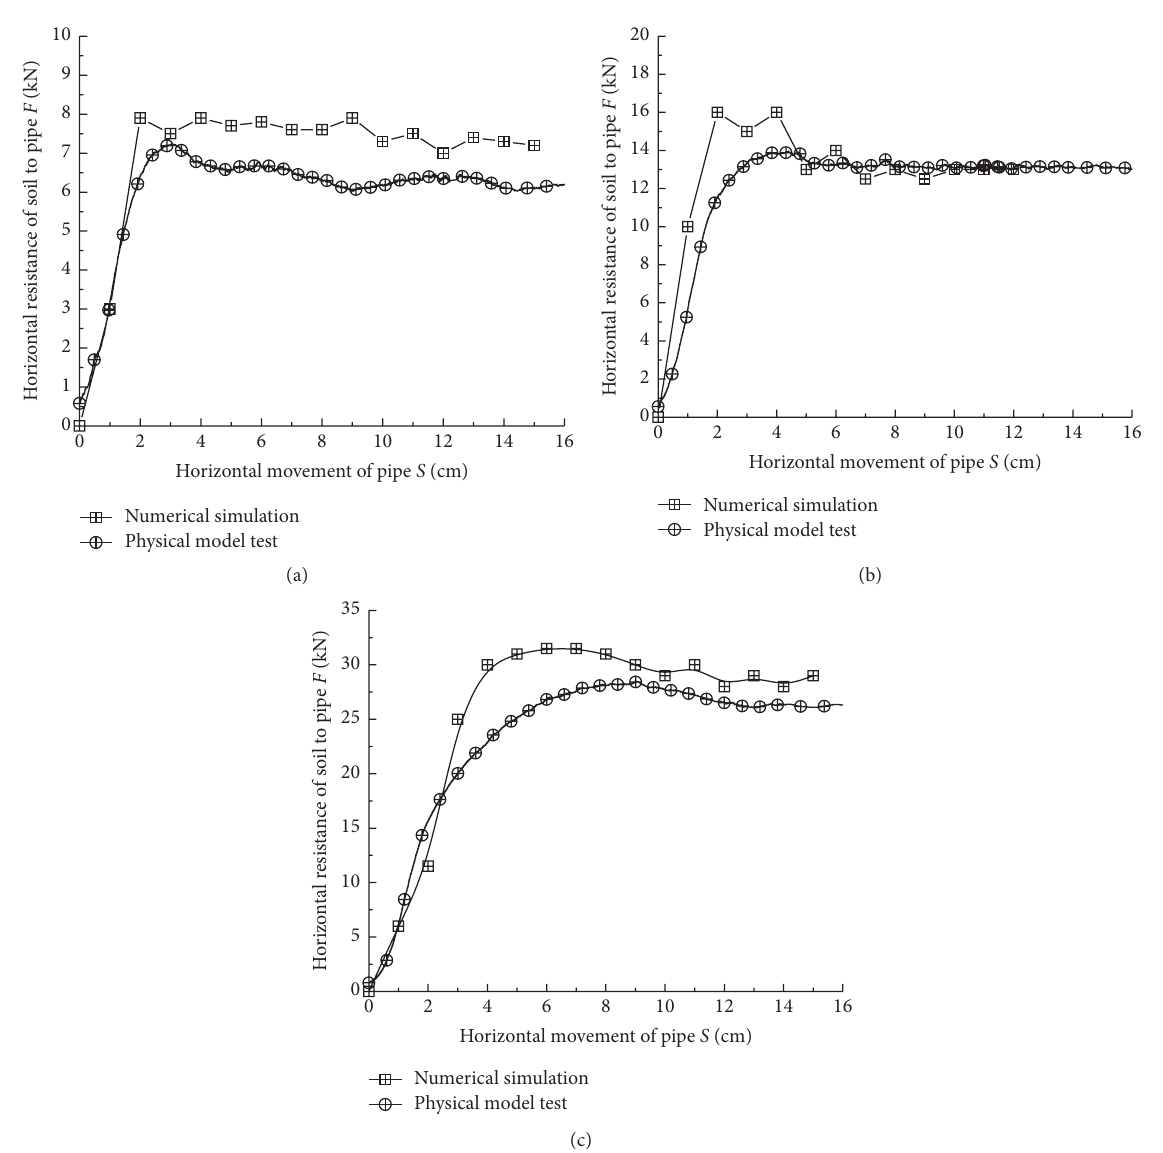
Figure 7: Load displacement curve under different H/D . (a) H/D � 1. (b) H/D � 3. (c) H/D �